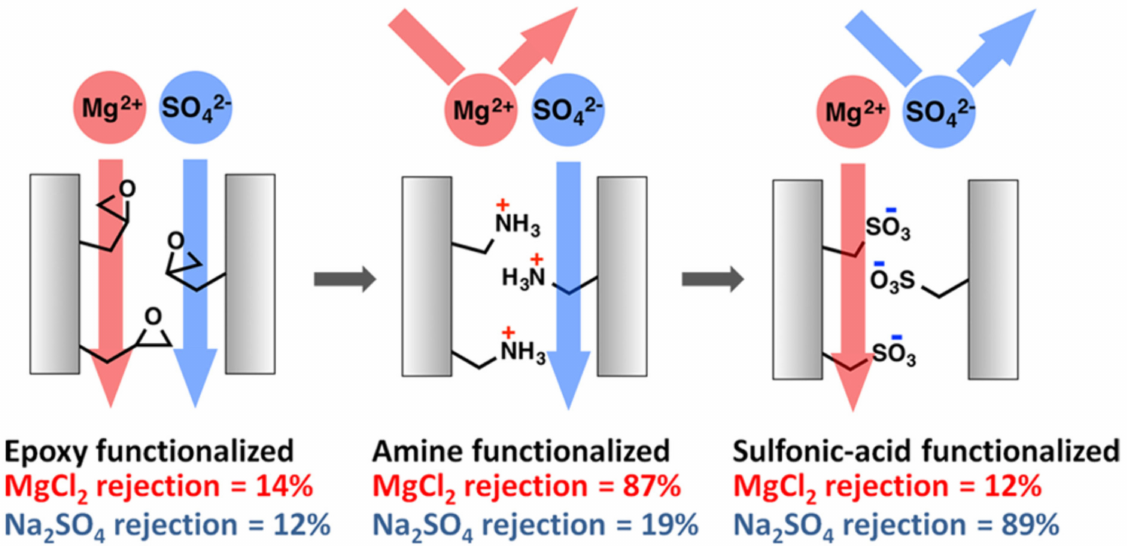
Figure 13. Membrane rejection properties based on surface functionalization. Provided with permis- sion from American Chemical Society